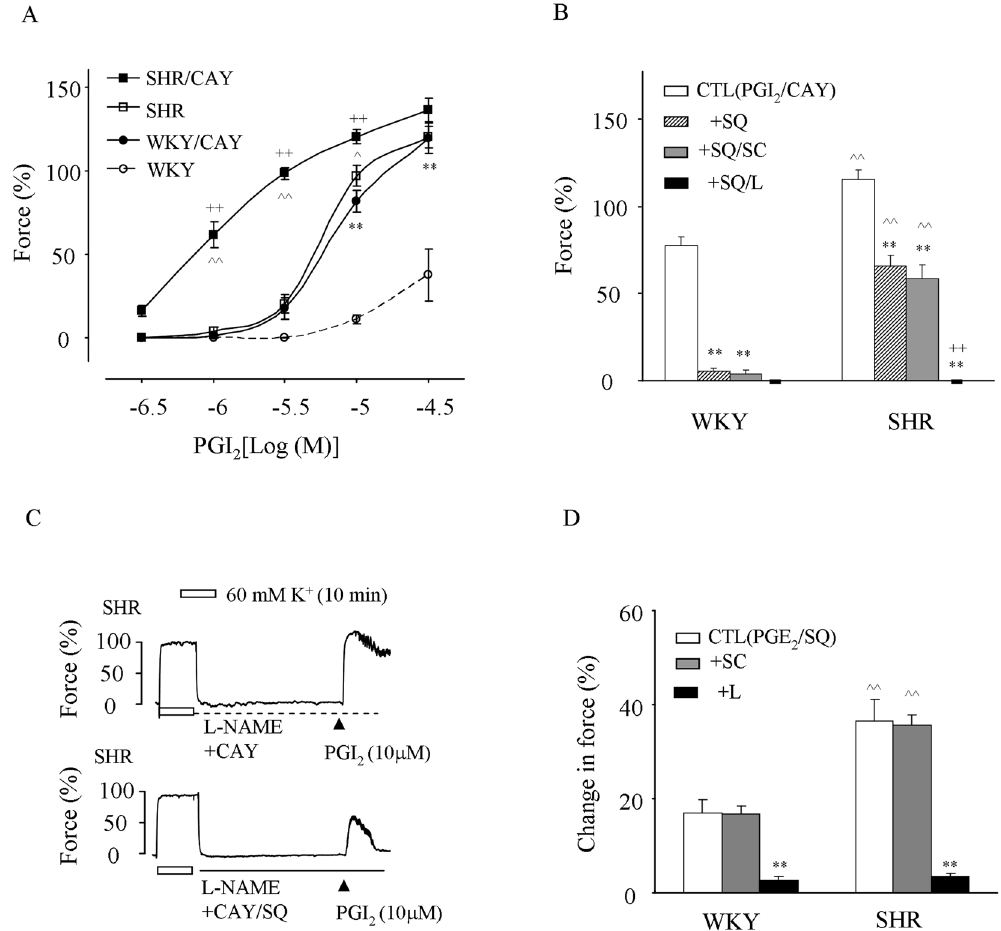
Figure 1. PGI 2 -evoked contraction in NOS-inhibited mesenteric resistance arteries and effect of EP3 antagonism. ( A ) Comparison of responses evoked by PGI 2 in L-NAME-treated WKY and SHR vessels with or without the presence of the IP antagonist CAY10441 (1 μ M; CAY). N = 5 for each; ** P < 0.01 vs. WKY; ^ P < 0.05 and ^^ P < 0.01 vs. SHR; ++ P < 0.01 vs. WKY/CAY. ( B ) Comparison of the control contraction evoked by PGI 2 (CTL; 10 μ M) in WKY or SHR vessels obtained with CAY with that additionally with the TP antagonist SQ29548 (10 μ M; + SQ), that with SQ29548 and the EP1 antagonist SC19220 (10 μ M; + SQ/SC), or that with SQ29548 and the EP3 antagonist L798106 (1 μ M; + SQ/L). ( C ) Representative traces showing the control contraction evoked by PGI 2 (10 μ M) in SHR vessels obtained with CAY (top) and that the additionally with the TP antagonist SQ29548 (10 μ M; bottom). ( D ) Summary of control responses evoked by PGE 2 (0.1 μ M) on the contraction evoked by PE (3 μ M) in L-NAME and SQ29548-treated WKY and SHR vessels and those obtained additionally with SC19220 ( + SC) or L798106 (1 μ M; + SQ/L). In ( B ) and ( D) , n = 5 for each; ** P < 0.01 vs. CTL; ^^ P < 0.01 vs. WKY counterparts; ++ P < 0.01 vs. +